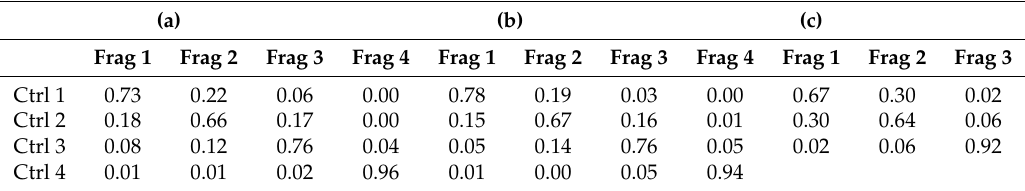
Table 6. Normalized confusion matrix for each heart region for ICA model, for ( a ) antero-septal, ( b ) lateral region, and ( c ) inferior region using ICA plus kurtosis. For each one, the ij value of the table represents the ratio of i -th component of control patient that is paired with the j -th component of synthetically fragmented patient according to the value of